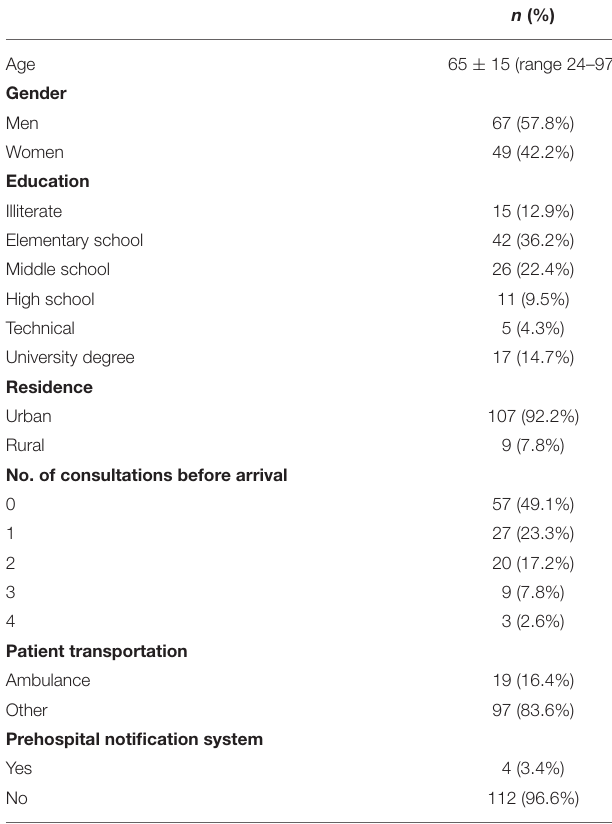
TABLE 1 | Demographic data and prehospital characteristics of patients arriving at the ED with any type of stroke ( n =